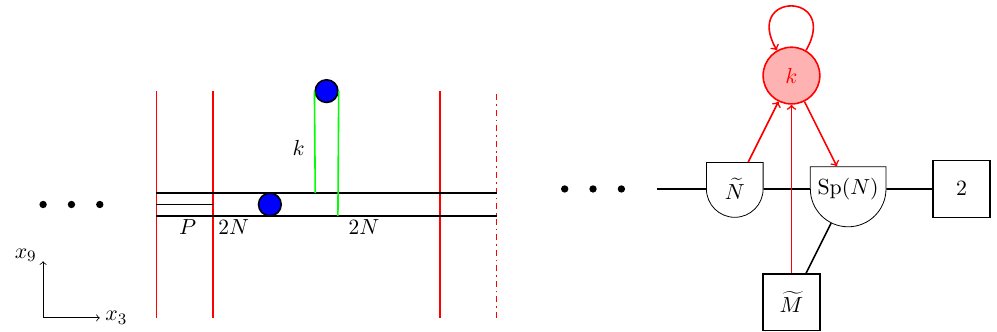
Figure 61 . S-dual of the configuration in figure 60. The red dot-dashed vertical line is an O5 0 -plane. The Type IIB configuration realizes a vortex defect for the Sp( N ) gauge group. This vortex defect can be understood as a deformation of a 3d-1d coupled quiver, which is shown on the